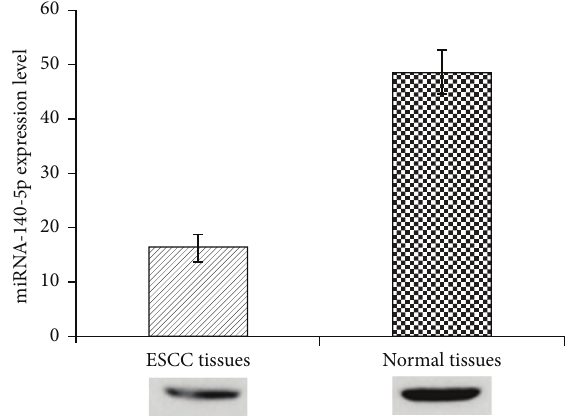
Figure 1: miR-140-5p expression in esophageal squamous cell car- cinoma and matched adjacent normal cells. The expression of miR- 140-5p in ESCC and normal cells was analyzed using immunoblot